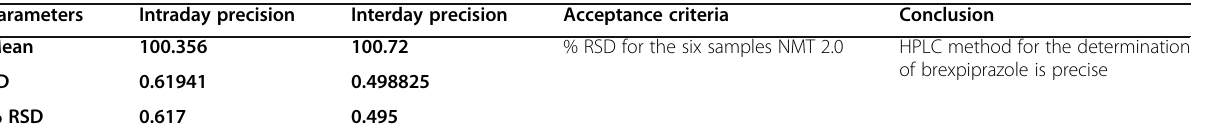
Table 12 Data of precision of